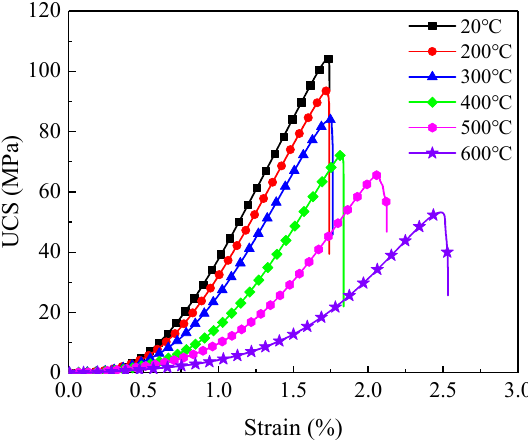
Figure 5. Stress-strain curves of specimens after thermal shock.